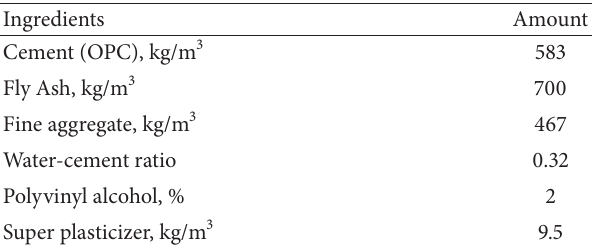
Table 1: Mix proportions of SC-ECC.